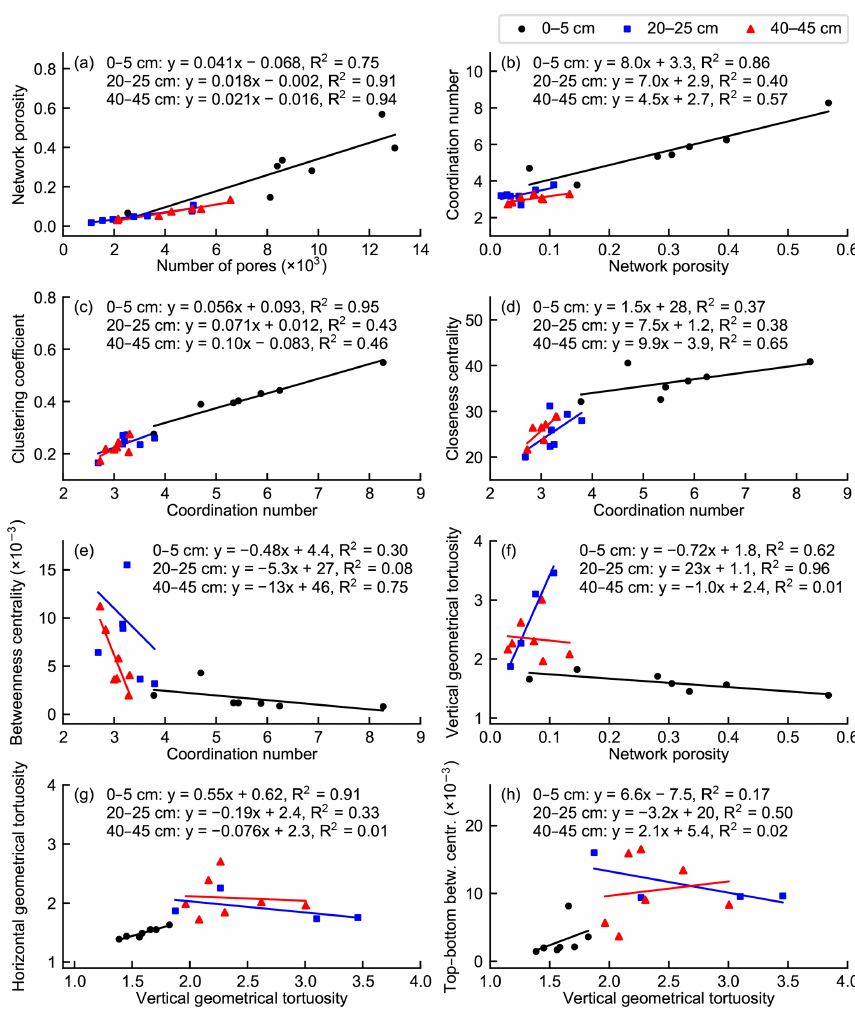
Figure 8. Linear relationships among selected pore network properties and average pore network connectivity